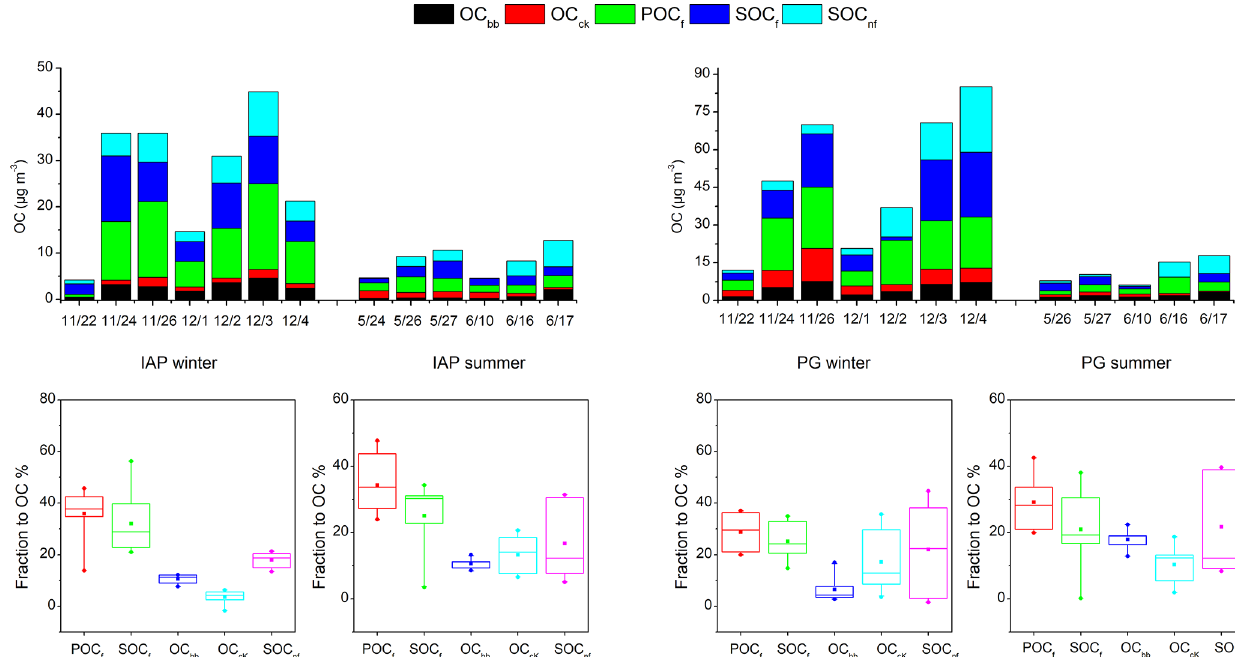
Figure 6. Time variations of OC source apportionment results by the extended Gelencsér method (upper) and the fractions of each source (i.e., POC f , SOC f , OC bb , OC ck , and SOC nf ) in OC based on the extended Gelencsér method (lower). f: fossil fuel sources, nf: non-fossil sources, bb: biomass burning, ck: cooking. The box denotes the 25th (lower line), 50th (middle line), and 75th (top line) percentiles; the solid squares within the box denote the mean values; the end of the vertical bars represents the 10th (below the box) and 90th (above the box) percentiles; and the solid dots denote maximum and minimum